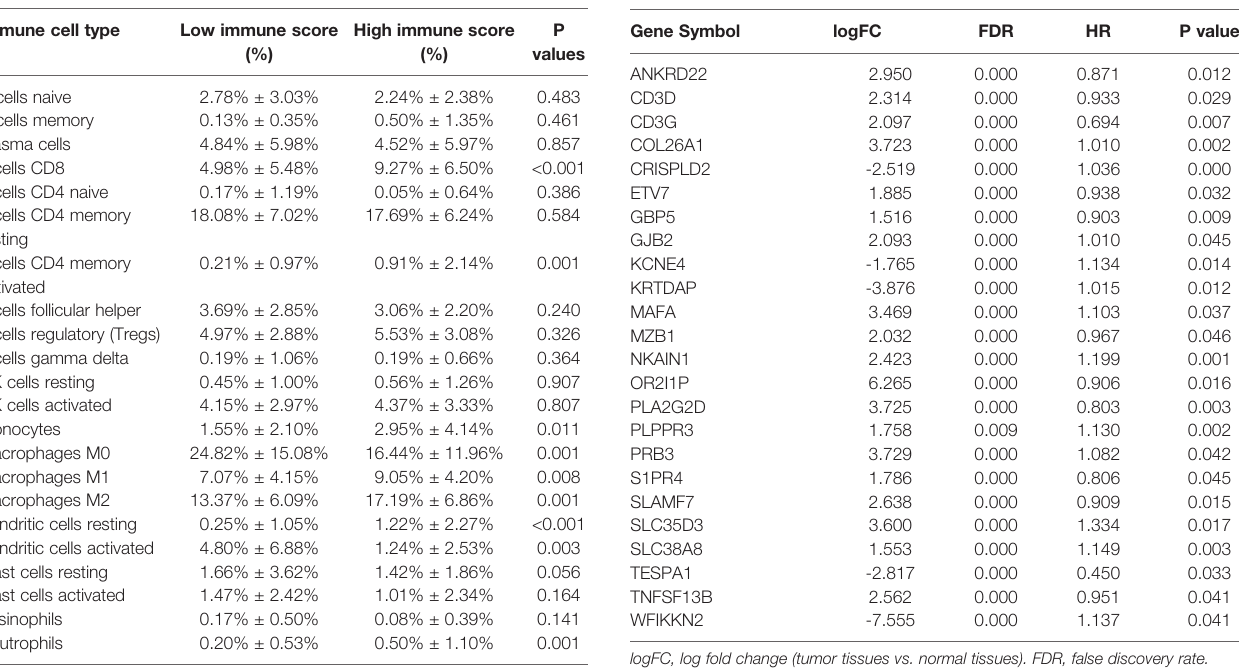
TABLE 2 | First reported immune microenvironment- related genes in